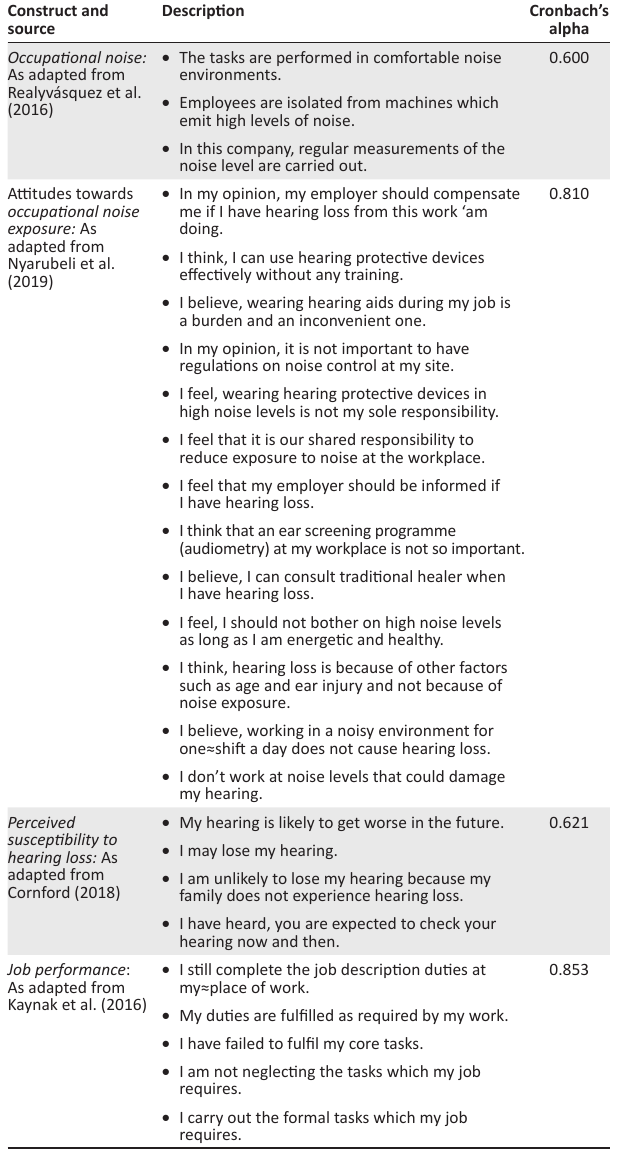
TABLE 1: Measurement scales and their